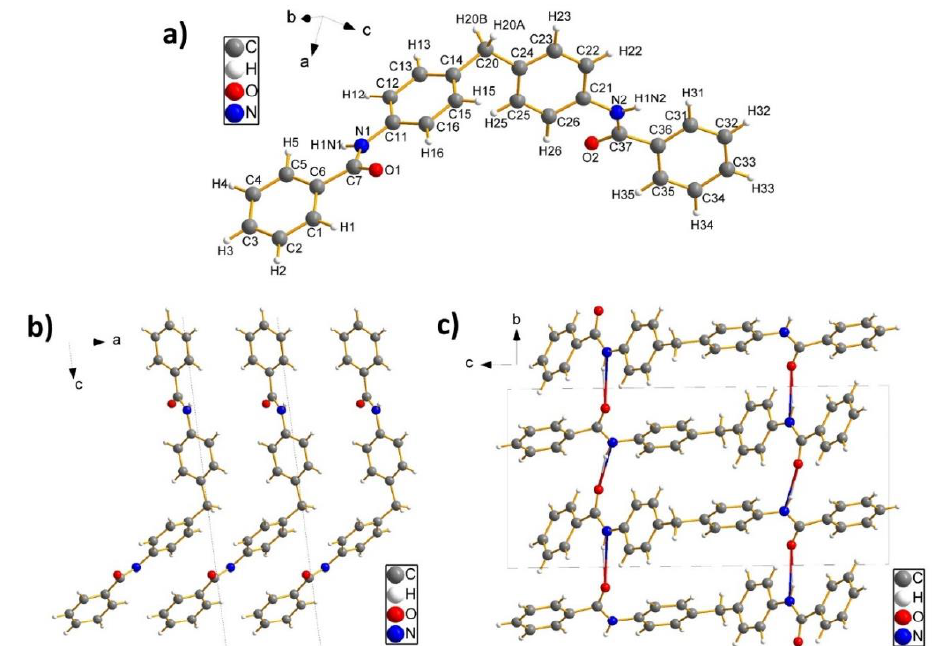
Figure 1. ( a ) Perspective view of an asymmetric unit of C 27 H 22 N 2 O 2 within a unit cell of BZ2. ( b ) Dense crystal packing of BZ2 molecules along the crystallographic a-axis (view along the crystallographic b-axis). ( c ) Crystal Packing of BZ2 molecules (view along the crystallographic a-axis) with hydrogen bonding networking (two-coloured bonds) running along the crystallographic b-axis.